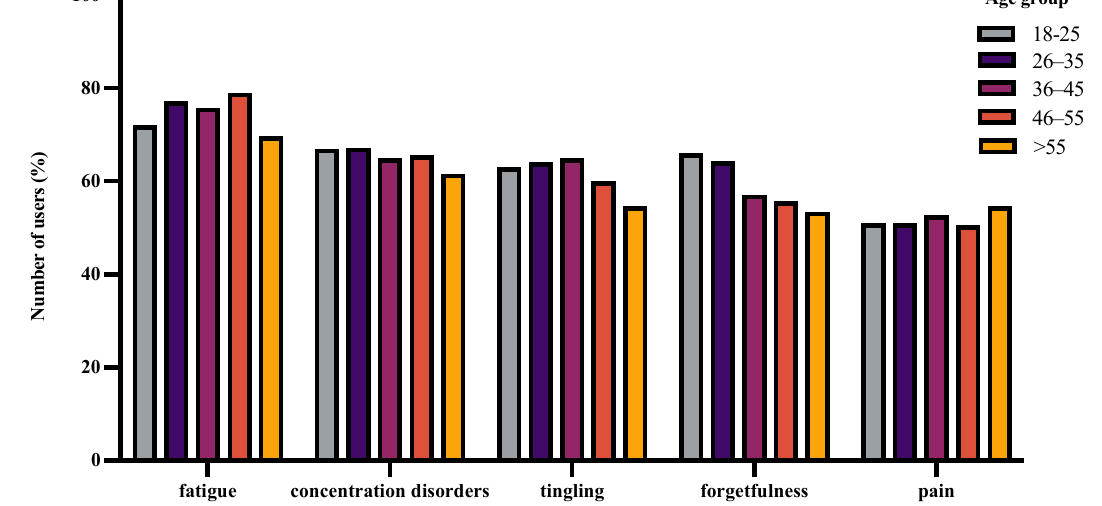
Figure 4. Distribution of the top five symptoms with age. The bar graph above shows the relative frequency of users who answered a specific symptom (normalized to the total number of unique users per age group who answered any symptom at least once). Each user could answer or track more than one symptom.